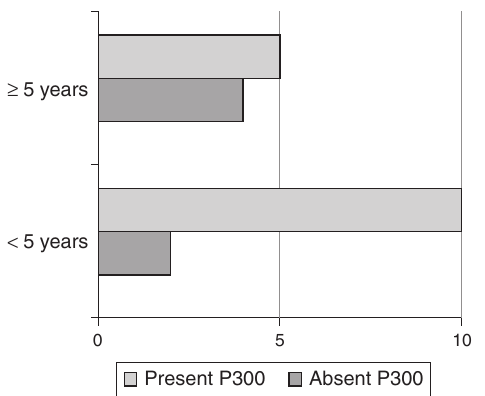
Association between P300 and patient age at the time of the beginning of the rehabilitation process.